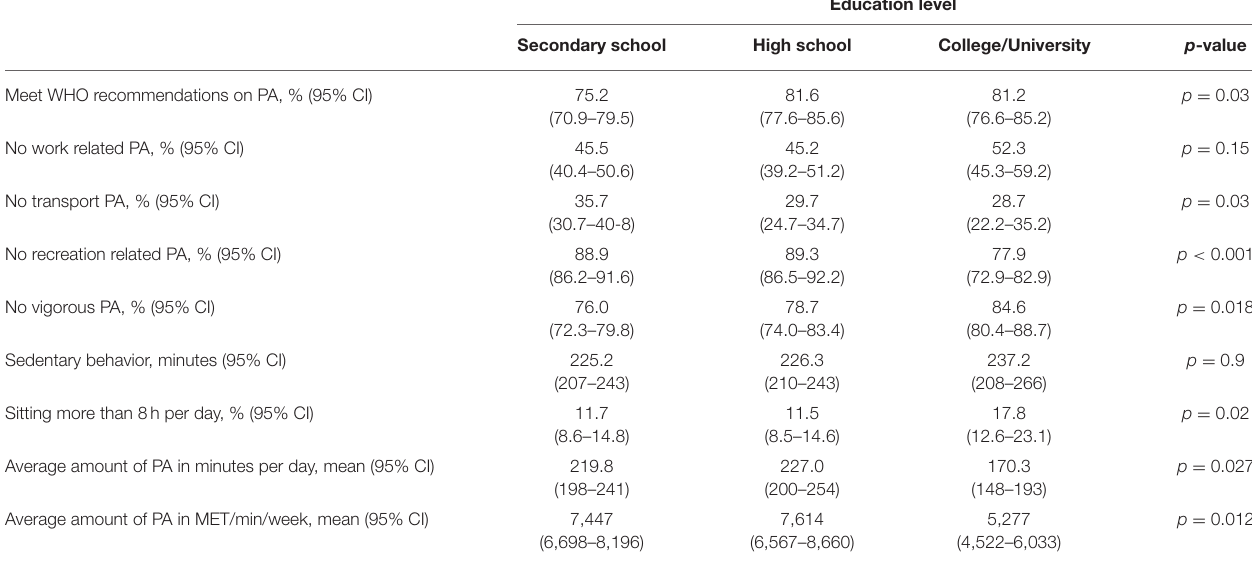
TABLE 5 | Indicators of physical activity and sedentary behavior for education